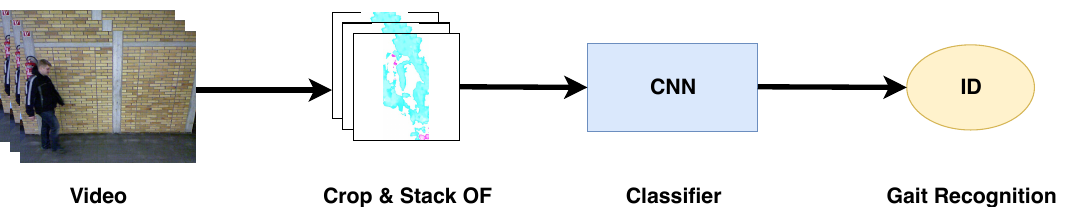
Figure 5. Pipeline for gait recognition. Pipeline based on References [24,41]. The input is a sequence of RGB frames where optical flow is calculated. Then, optical flow is cropped and stacked in 25-frame subsequences, keeping the subject centered in the 13th frame. Finally, the subsequences are passed through a CNN and classified by a SoftMax layer.